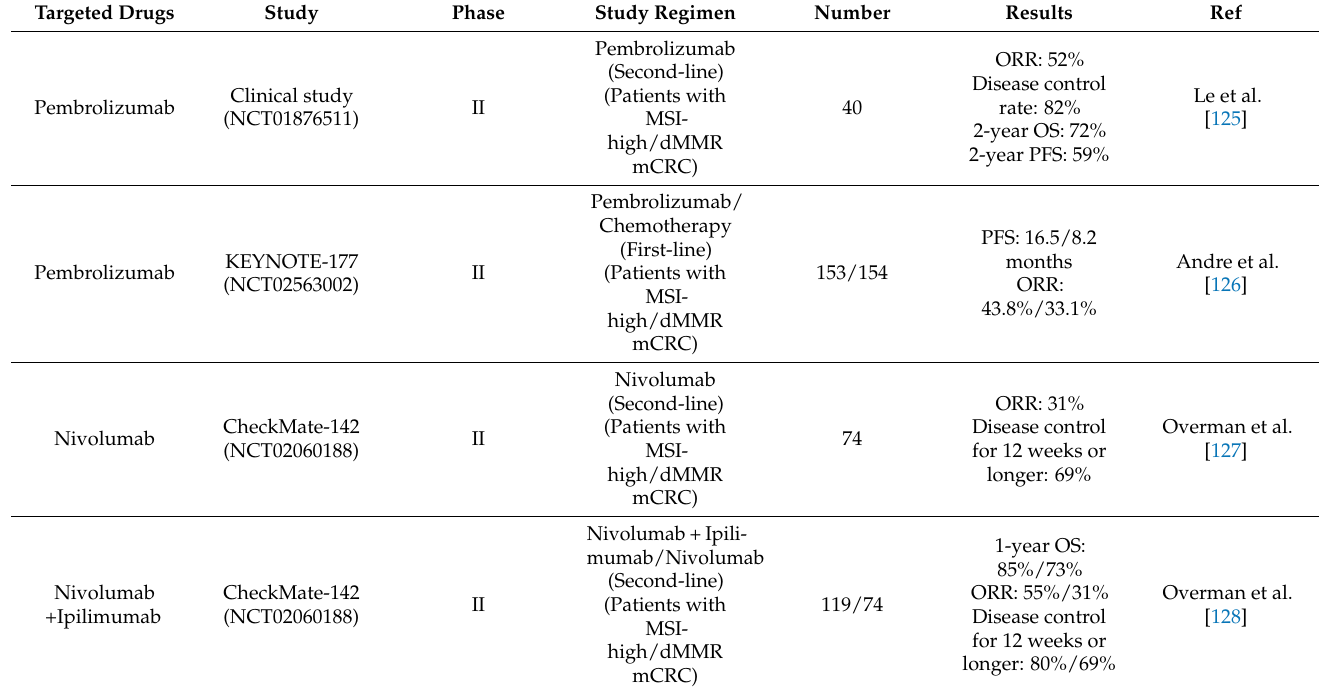
Table 4. Selected clinical trials for immune checkpoint-targeting